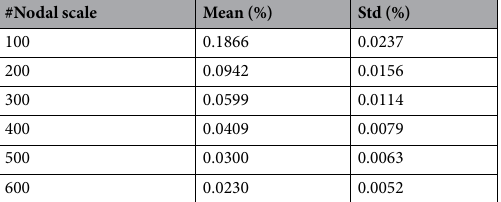
higher hub scores than regions of red color (Fig. 1, top). We identified group hubs according to the average betweenness centrality map that were one standard deviation above the mean (see Methods). Hubs of networks at multiple scales were highlighted in yellow (Fig. 1, bottom). The anatomical location of the hubs can be repre- sented from the pre-defined template 28 and abbreviations for the cortical regions were listed in Supplementary Table S2. Note that most of the hub regions almost overlapped, among which six cortical regions (precuneus, cuneus, superior temporal gyrus, superior frontal gyrus, superior parietal gyrus, and superior occipital gyrus) appeared as hubs in a bilaterally symmetric fashion between nodal scales. In addition, four brain regions (right middle occipital gyrus, right inferior frontal gyrus, left inferior frontal gyrus, and left Heschl’s gyrus) were con- sidered as hubs only for the coarsest scale; whereas, three different brain regions (right anterior cingulate and paracingulate gyri, left precentral gyrus, and right precentral gyrus) were identified as hubs only in the finest scale. Supplementary Table S3 showed the anatomical locations of the hubs at multiple scales (100–600 scales) and ratio of each hub region compared with pre-defined template. H region distribution. The H IS IS _ ST map was shown to demonstrate the overall network hub pattern between multiple nodal scales (Supplementary Figure S1). Figure 2 showed H IS regions with H IS _ SC greater than one stand- ard deviation above the mean of the H IS _ ST map. Note that, as shown in Table 2, H IS included the regions precu- neus, superior occipital gyrus, superior parietal gyrus, insula, superior temporal gyrus in a bilaterally symmetric fashion, and right cingulum. Additionally, some regions of the precuneus, superior occipital gyrus, and superior parietal gyrus in a bilaterally symmetric fashion had a relatively higher level of H IS _ SC than other regions of the insula, superior temporal gyrus in a bilaterally symmetric fashion, and right cingulum.